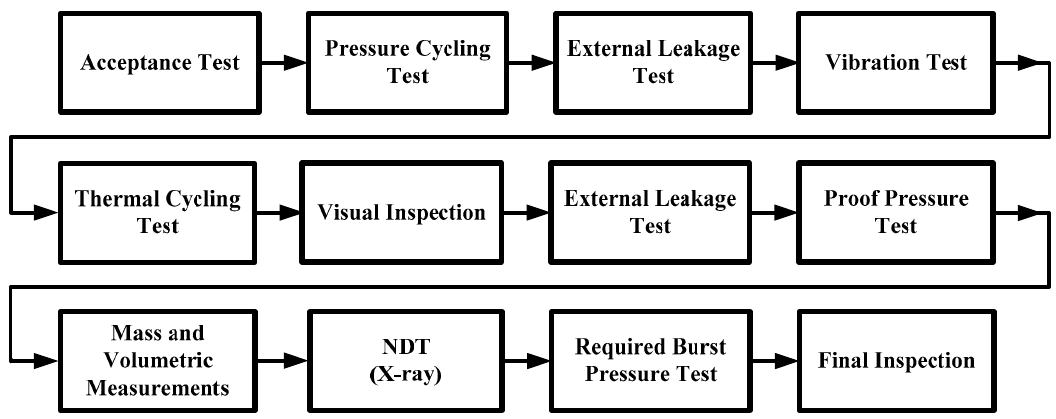
Figure 6. Flow chart showing the qualification process of the propellant tank for the Adelis-SAMSON nano-satellite.